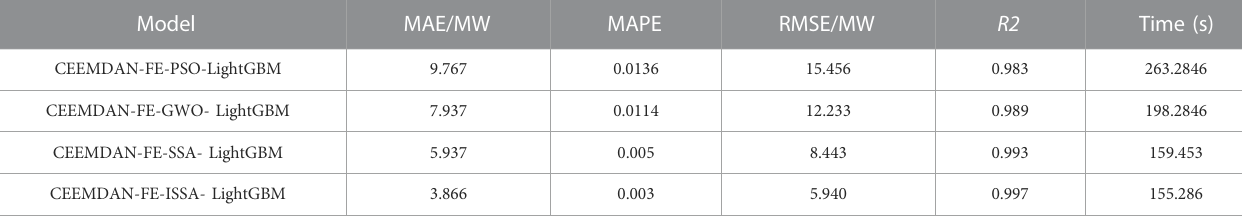
TABLE 8 Error comparison of the proposed model with other hybrid models in